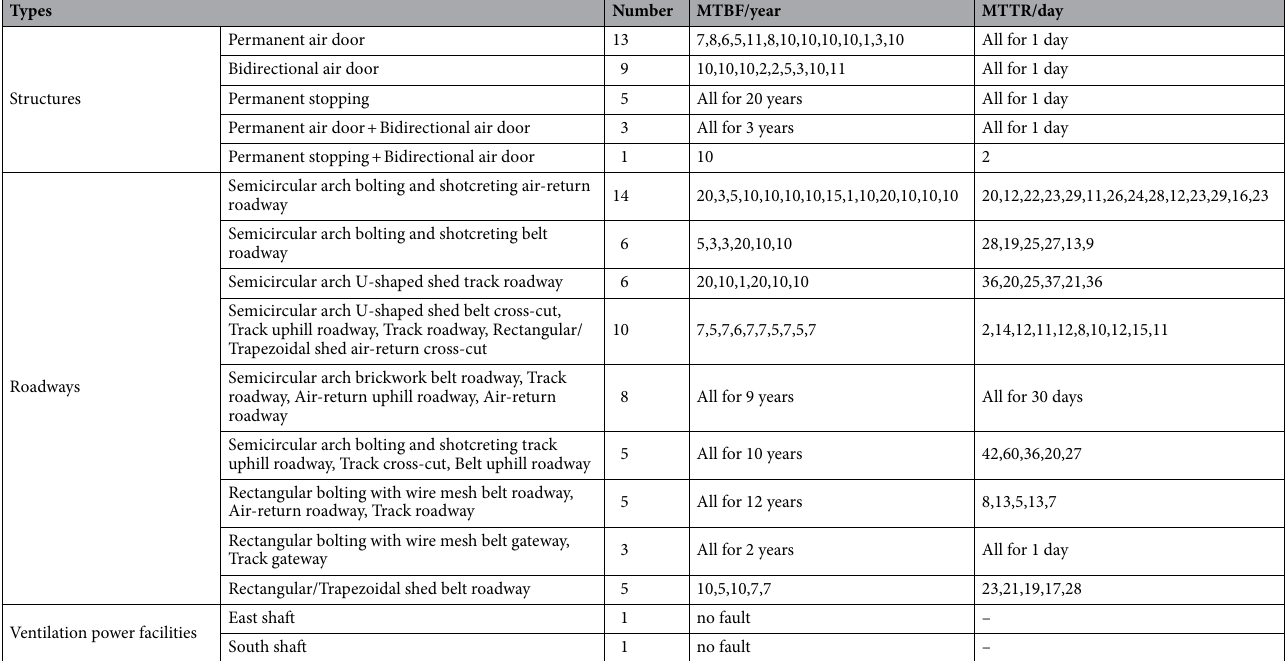
Table 2. XQ mine maintenance cycle and repair time